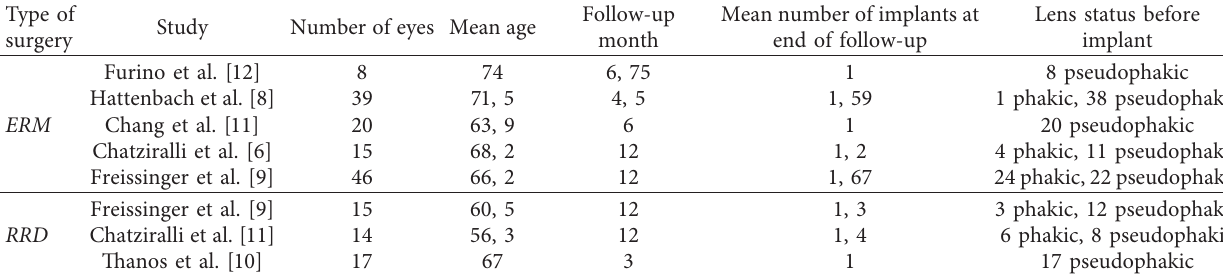
Table 1: Characteristics of the included